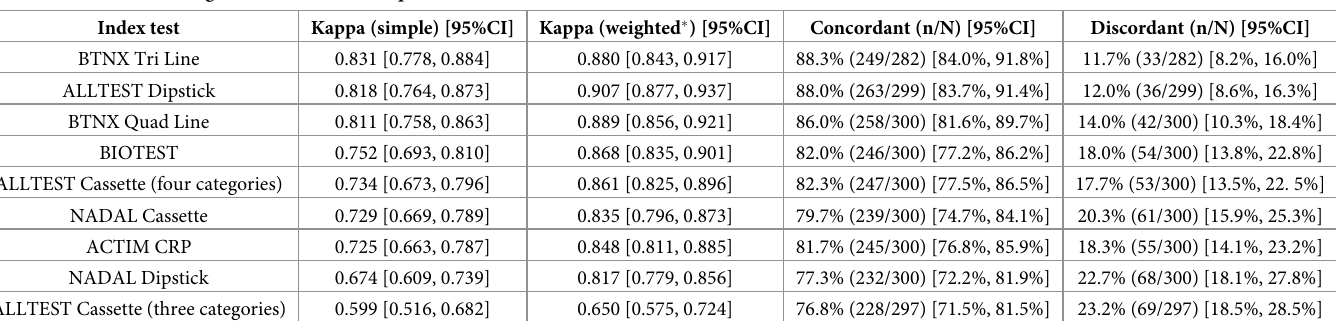
Fig 4. Agreement plots (Bangdiwala plots) for semi-quantitative tests. Y-axis: categories using measurement values of the reference method, X-axis: categories according to the different index tests (units are mg/L). The horizontal width refers to the number of measurement results in the category. The gray shading refers to varying degrees of agreement (darker gray = a better degree of agreement). Overall, a good agreement is indicated by a square shape, with corners on the diagonal identity line and a large amount of dark gray filling the area. https://doi.org/10.1371/journal.pone.0267516.g004 Table 5. Between-reader agreement for the semi-quantitative